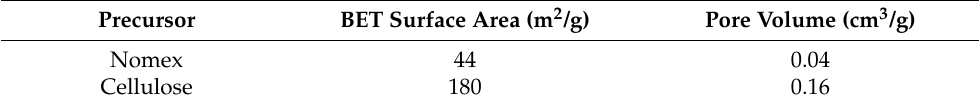
Table 2. BET surface area and pore volume of Nomex and cellulose-derived carbon